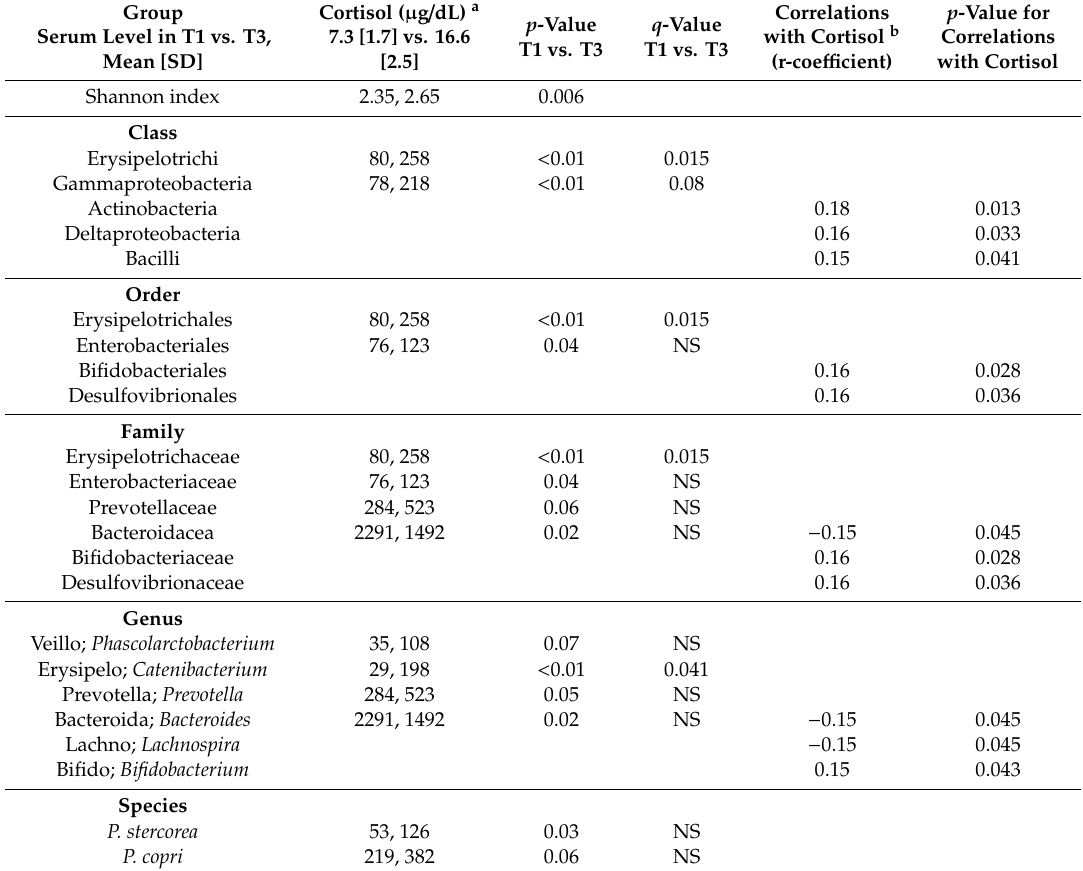
Table 5. Comparisons and correlations of microbiota by cortisol